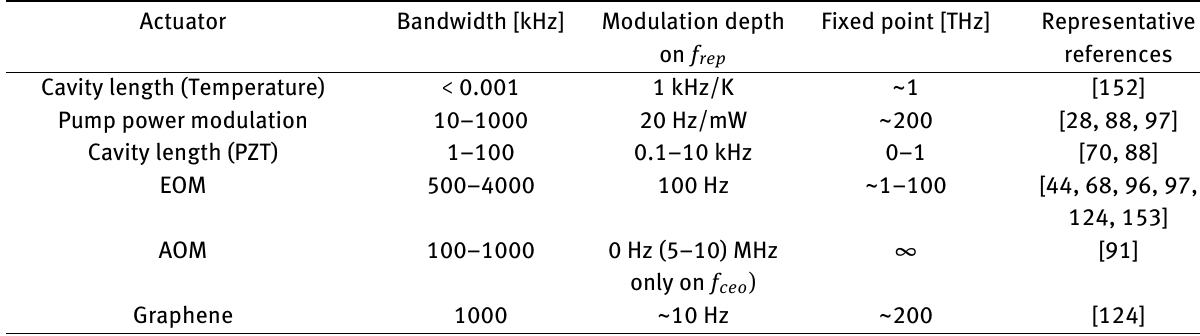
Table 2: List of actuators used for the stabilization. Note that all values are approximate and for f rep = 100 MHz; actual values can vary significantly depending on actuator and laser